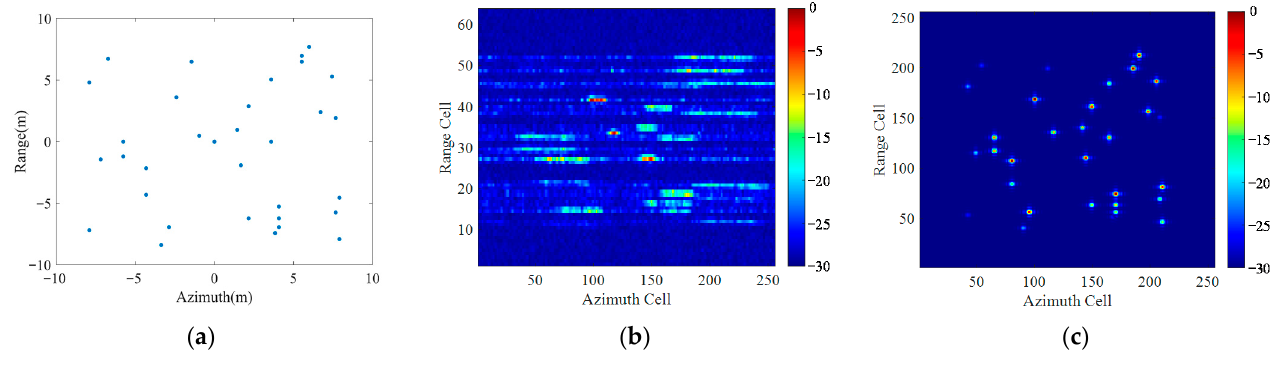
Figure 9. An example of the training data: ( a ) The coordinate distribution of the scattering points; ( b ) The blurred ISAR imaging result by RD method; ( c ) The ideal ISAR image.